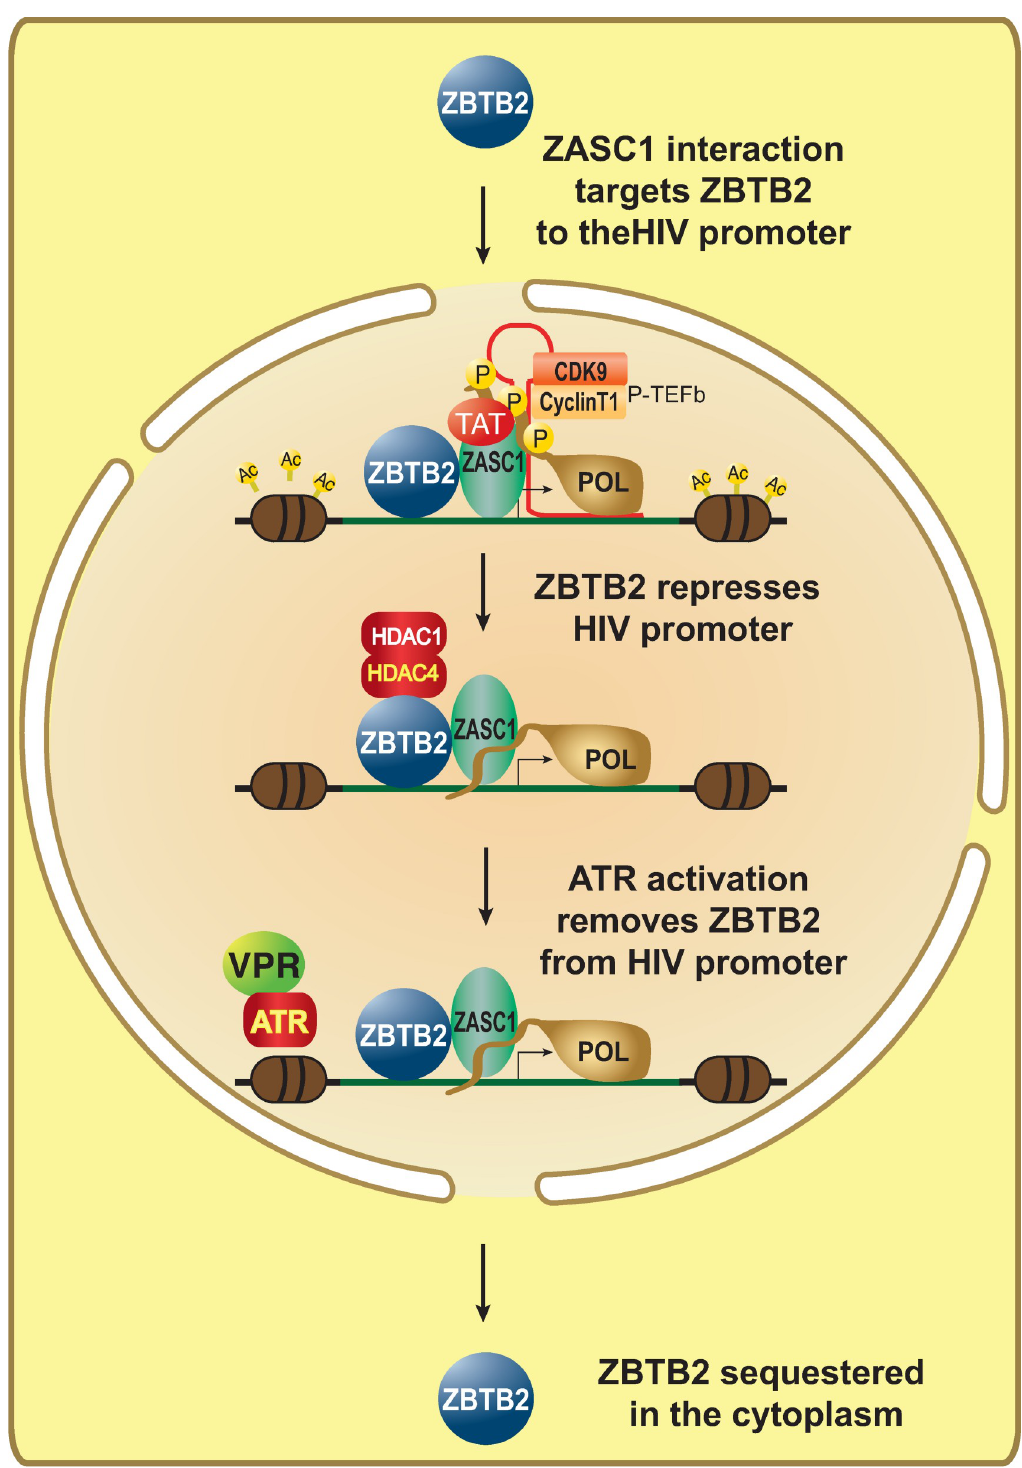
Fig 13. Model for ZASC1 and ZBTB2 regulation of HIV-1 transcription. In the presence of Vpr or other activation of the DNA damage response, ZBTB2 is exported from the nucleus, ZASC1 binds the HIV-1 LTR promoter and facilitates the assembly of the TAT P-TEFb elongation complex. Under conditions of low Vpr, ZBTB2 is recruited to the HIV-1 promoter by ZASC1, binds cellular HDAC complexes and represses HIV-1 transcription.